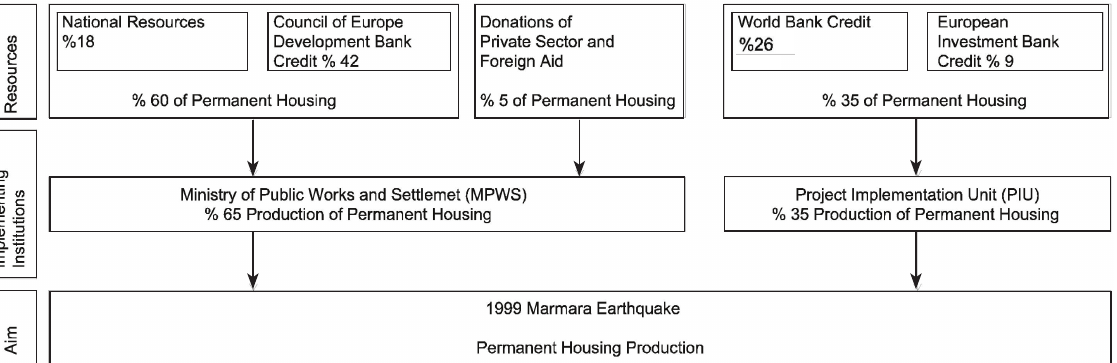
figure 3. Marmara earthquake permanent housing production